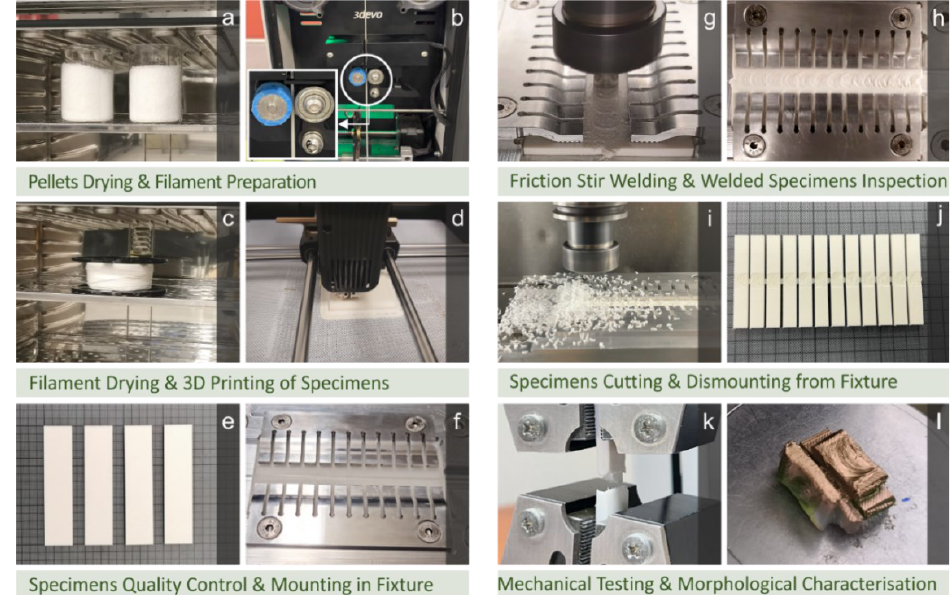
Figure 2. ( a ) Raw material drying, ( b ) filament extrusion, ( c ) filament drying, ( d ) workpieces 3D printing, ( e ) workpieces for the FSW process, ( f ) FSW experimental setup, ( g ) FSW experiments, ( h ) FSW process weld seam, ( i ) workpiece cutting in the milling machine, ( j ) workpieces dismounted from the fixture, ( k ) tensile testing, and ( l ) SEM morphological